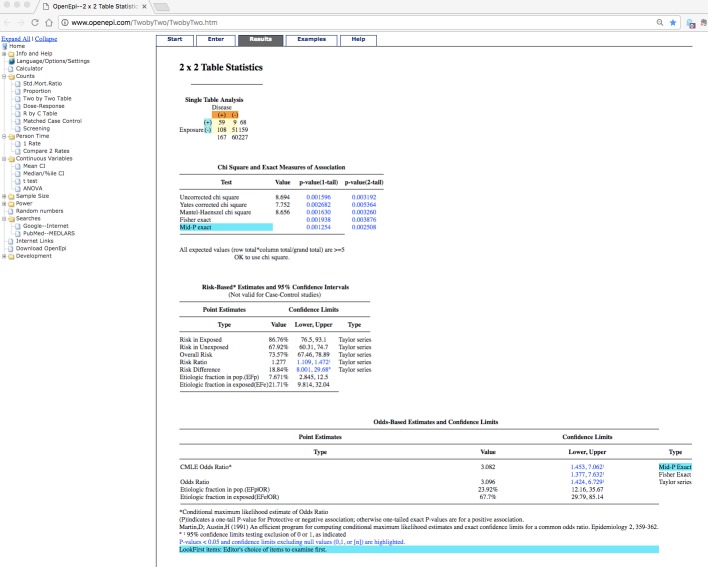
DOI:
http://dx.doi.org/10.7554/eLife.25461.020